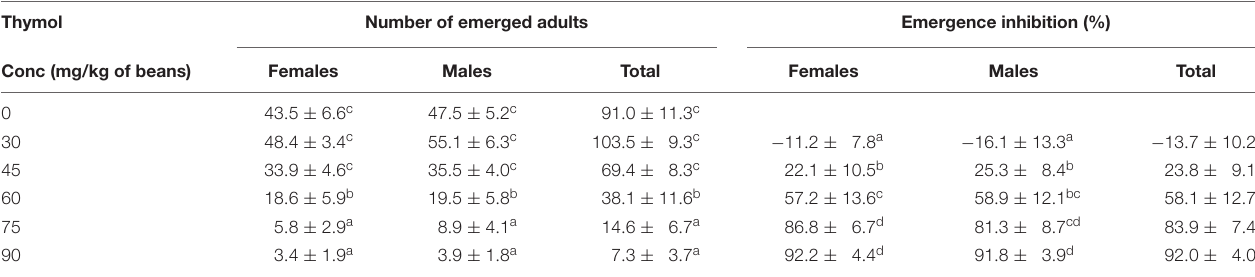
TABLE 3 | Adult emergence in F1 generation and emergence inhibition (means ± SE for 8 replicates) in Acanthoscelides obtectus depending on thymol concentration (Conc) in parental generation. Thymol Number of emerged adults Emergence inhibition (%) Conc (mg/kg of beans)